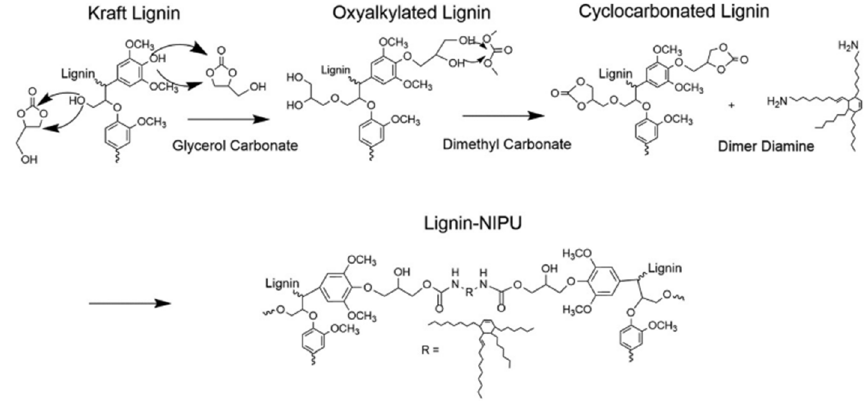
Figure 11. Strategy for the functionalization of kraft lignin to produce NIPU [192].